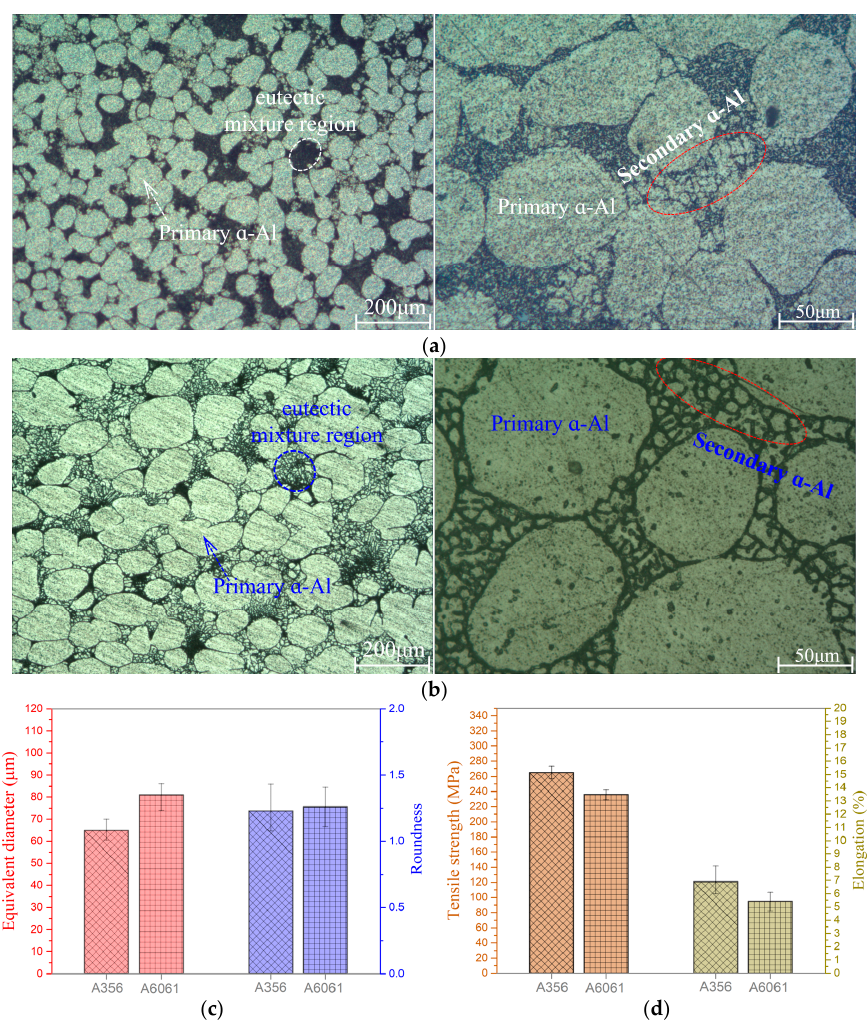
Figure 8. Final samples by forming process using semi-solid billets: ( a ) A356 microstructures; ( b ) A6061 microstructures; ( c ) equivalent diameter and roundness of primary α -Al grains; ( d ) tensile strength and elongation.